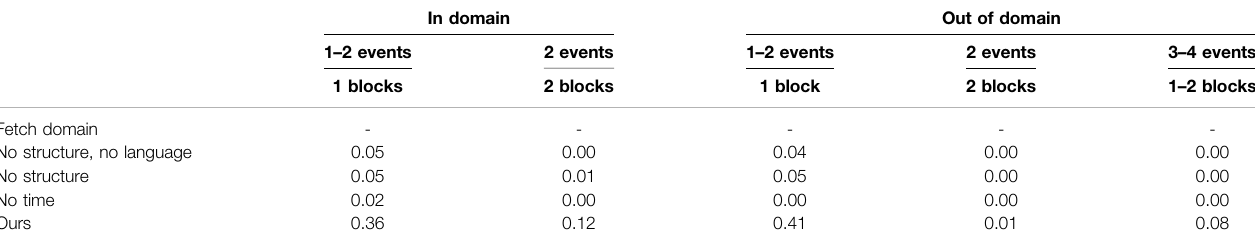
TABLE3| Thesuccessrateofourmodel fi ndingsatisfyingactionsforLTLformulasinFetchdomain.Theformulasforin-domainandout-of-domainsaregroupedbynumber of event and number of blocks the robot should interact with during the command execution. In